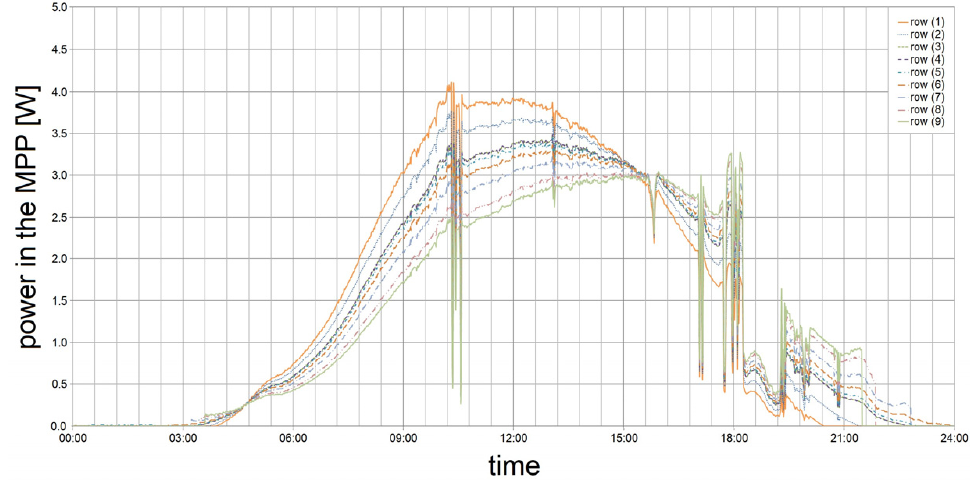
Figure 23. Simulated power at MPP ( P mpp ) for ψ = 135°.